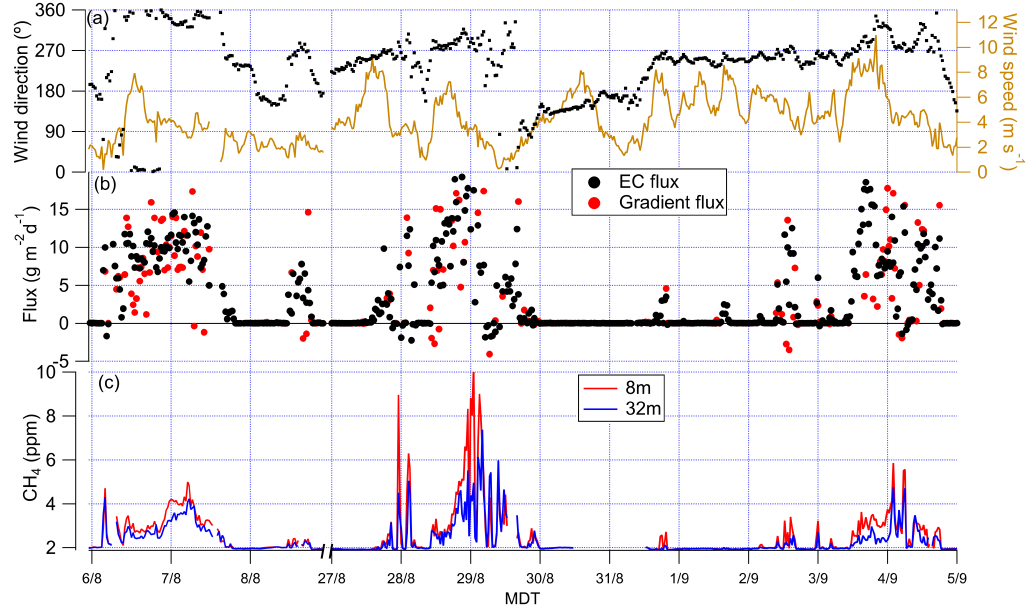
Figure 6. Time series of (a) wind direction and wind speed, (b) CH 4 EC fluxes and gradient fluxes, and (c) CH 4 mole fractions at 8 and 32m, from 6 to 9 August and from 27 August to 5 September.